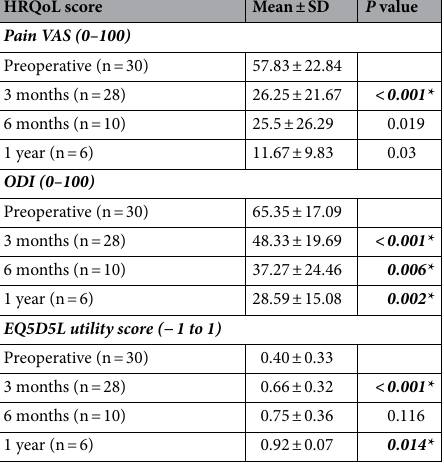
Table 3. Patient health-related quality-of-life (HRQoL) scores compared between preoperation and each follow-up visit until 1 year after surgery. *Indicates a statistically significant difference ( p < 0.017) (alpha level was adjusted using Bonferroni method). VAS, visual analog scale; ODI, Oswestry Disability Index; EQ5D5L utility score, EuroQOL five-dimension five-level utility score.